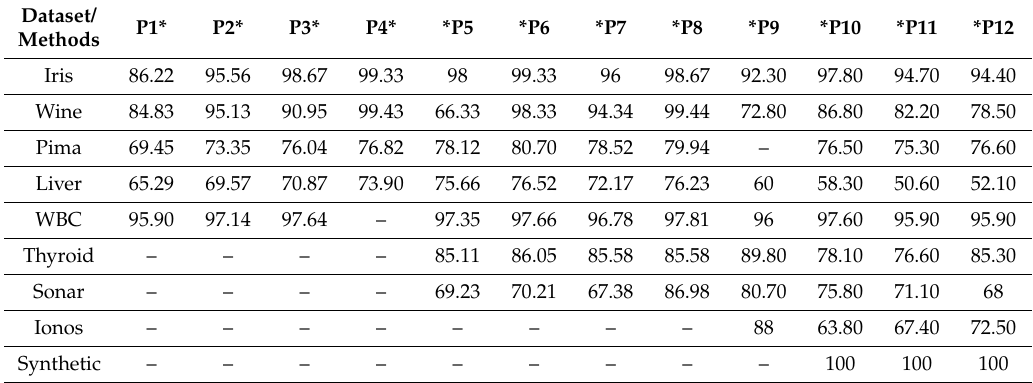
Table 8. Performance comparison with some other schemes.